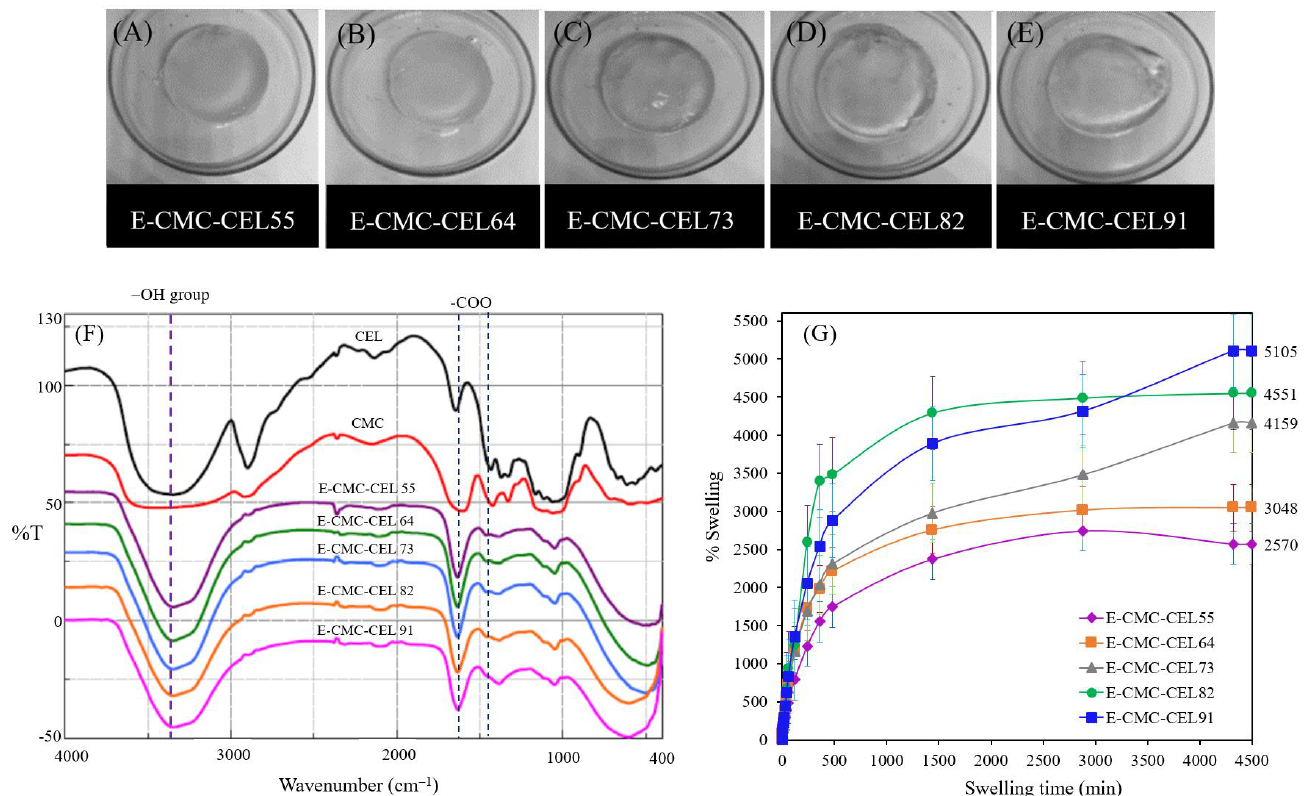
Figure 5. The shape of E-CMC-CEL gels with ECH as a crosslinker; ( A ) E-CMC-CEL55, ( B ) E-CMC- CEL64, ( C ) E-CMC-CEL73, ( D ) E-CMC-CEL82, ( E ) E-CMC-CEL91, ( F ) FT-IR spectra of E-CMC-CEL gels by using ECH as a cross linker and ( G ) %swelling of CMC-CEL gels with ECH cross linker in distilled water at 25 °C for 72 h.